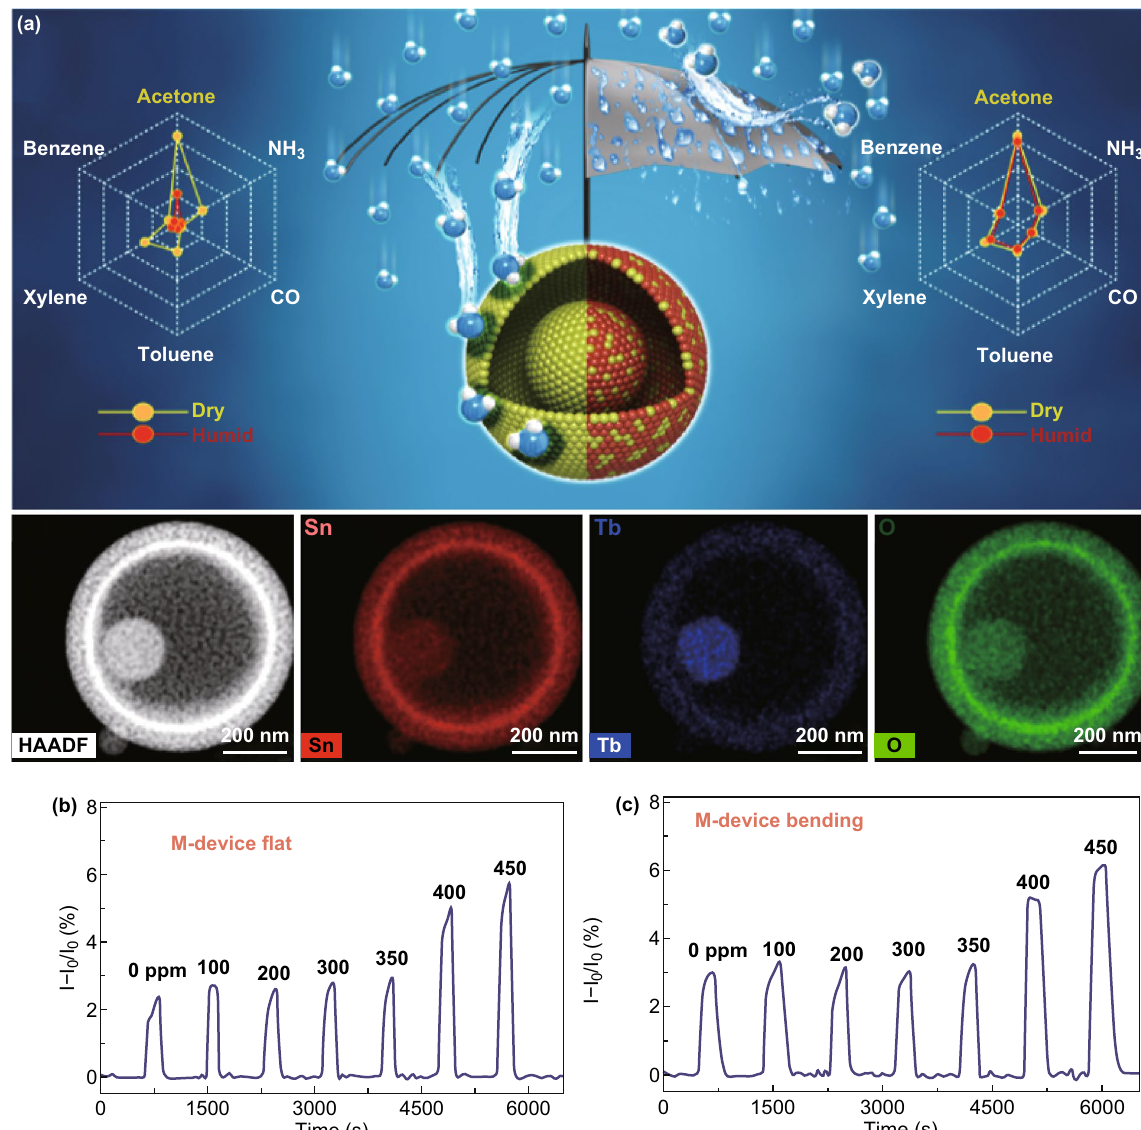
Fig. 16 a Polar plots of the gas responses of pure SnO 2 and 5 Tb–SnO 2 sensors exposed to different gases (at 20 ppm) in dry (yellow) and RH 80% (red) atmospheres, and EDS elemental mapping of Sn, Tb, and O in 5 Tb–SnO 2 . Reproduced with permission [128]. Copyright 2018, American Chemical Society. b, c Response curves to 1-hexanal at different humidity in bending and flat states. Reproduced with permission [82]. Copyright 2018, Wiley–VCH. (Color figure